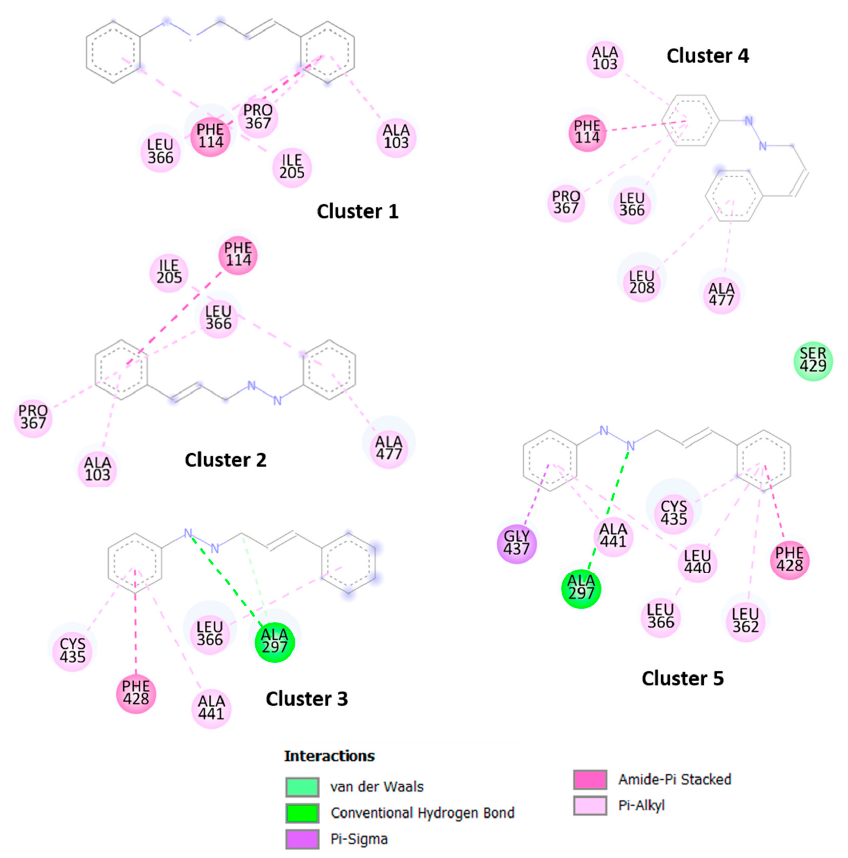
Figure 3. Here, 2D representation of interaction types of CPH with CP-450 enzyme for the first five clusters.